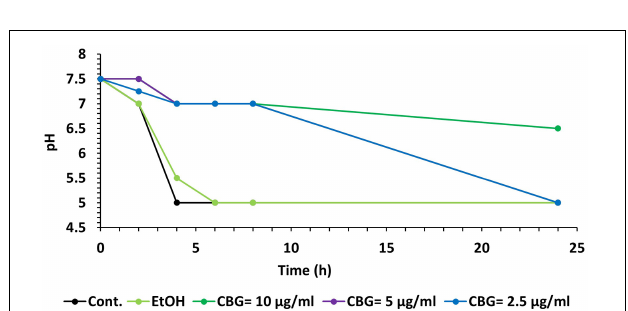
FIGURE 9 | CBG prevents the decrease in pH caused by S. mutans . A kinetic change in the pH values of the medium of untreated and CBG (0–10 µ g/ml)-treated S. mutans